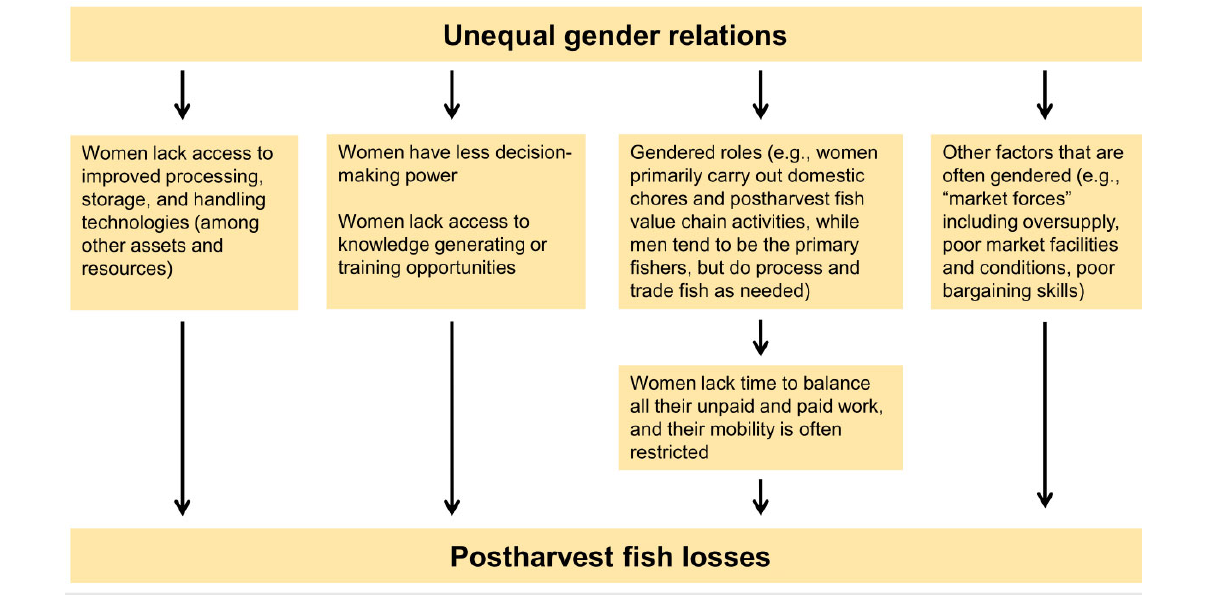
Fig. 4 . Unequal gender relations as an underlying cause of postharvest fish losses in the Barotse Floodplain